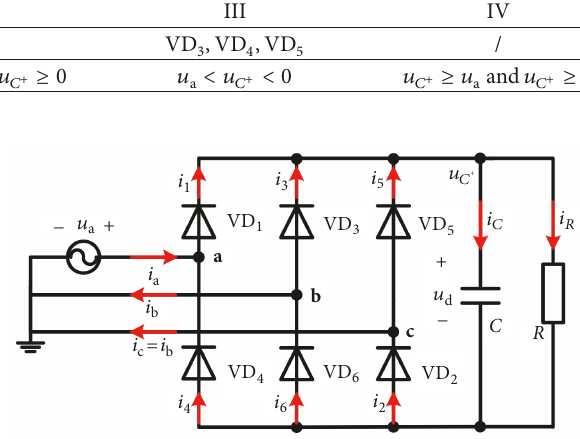
Figure 9: Equivalent circuit of three-phase bridge rectifier circuit running under single-phase short-circuit condition.